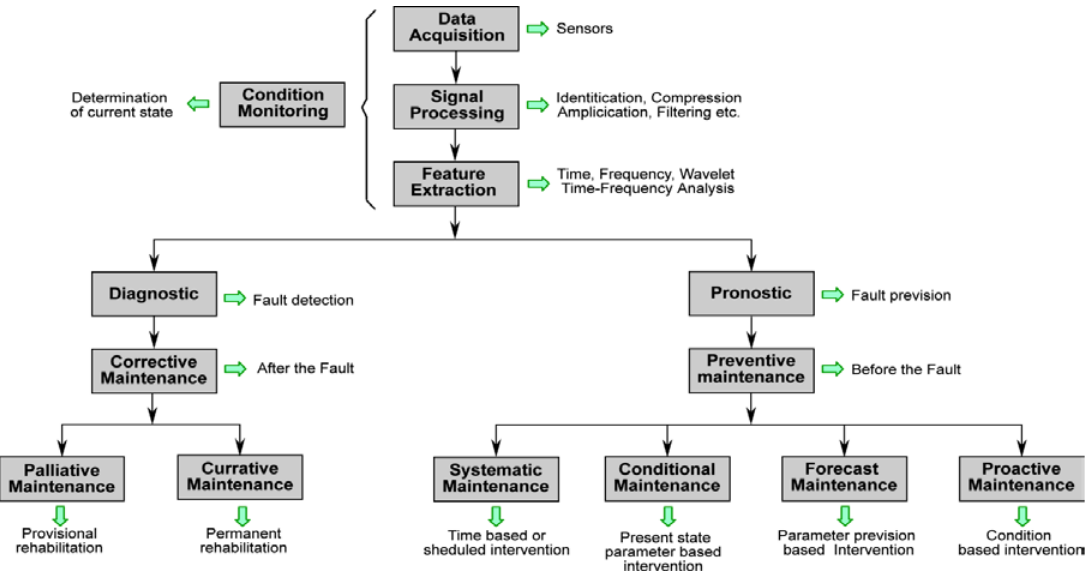
Figure 7. Overview of condition-monitoring (CM) and maintenance processes for